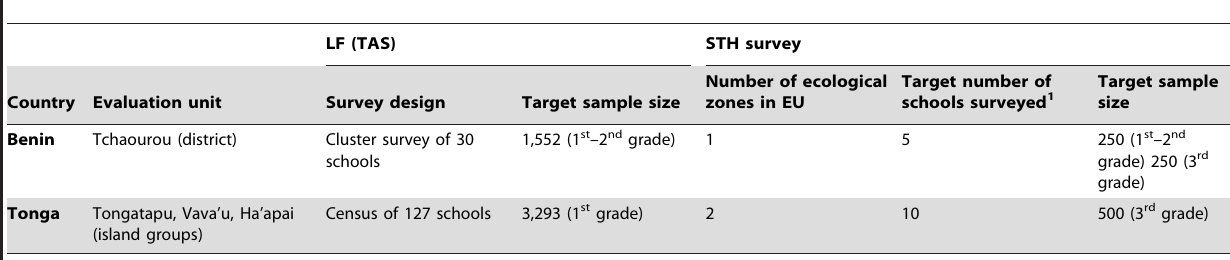
Table 3. Sampling strategy for coordinated TAS and STH surveys.